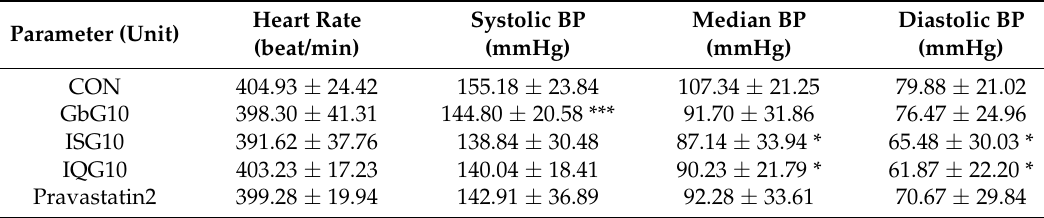
Table 1. Blood pressure values of insect glycosaminoglycan in rats on a high fat diet over a one month period.